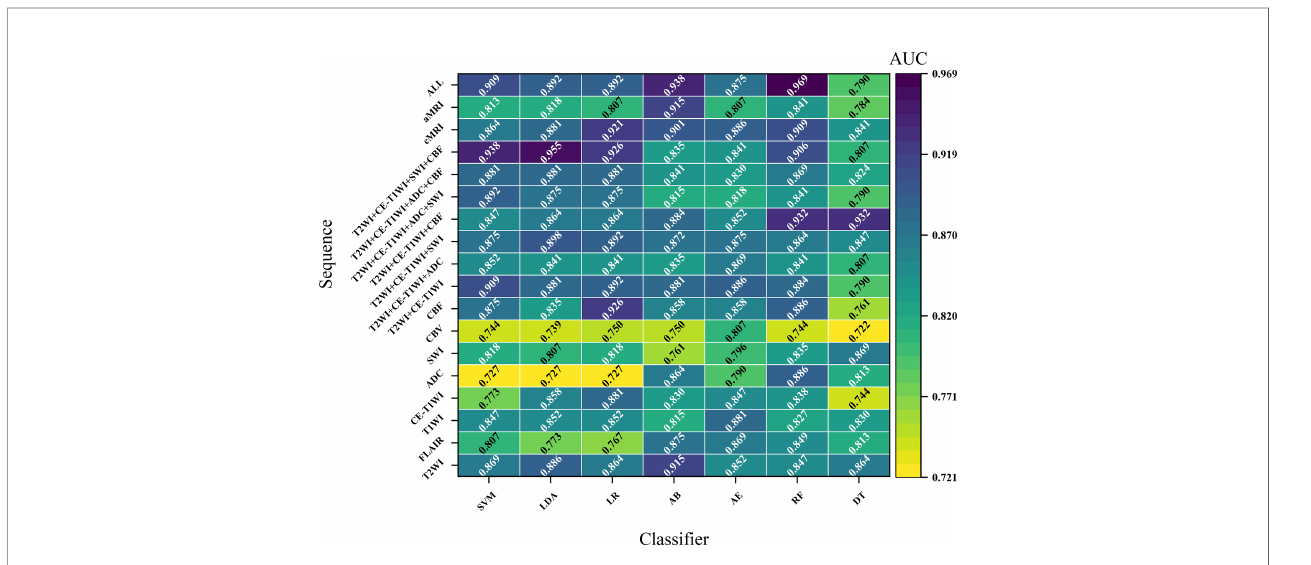
FIGURE 5 | The optimal performance across different sequences and classi fi